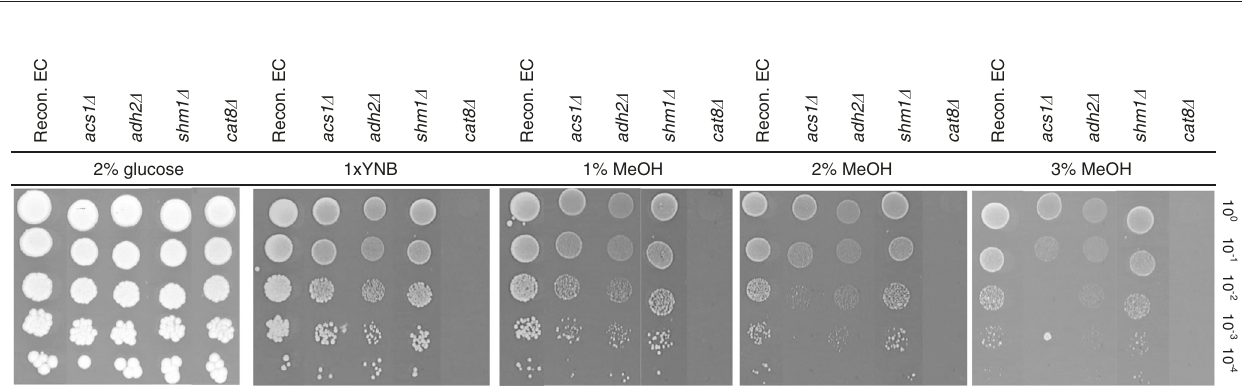
Fig. 4 Characterisation of the reconstructed evolved strain at the metabolite, transcriptome and proteome level compared with the parental strain during 13 C-methanol fermentations. Percentage of 13 C-labelled intracellular metabolites in CEN.PK 113-5D (black) and the reconstructed evolved strain (purple). Metabolites are fully labelled with 13 C. Data points represent the average of two independent biological replicates with standard deviation. Transcript and protein abundance in the reconstructed evolved strain compared with the parental strain. Genes with up- or downregulated fold-changes and adjusted p values <0.01 are coloured blue or yellow, respectively. Increased or decreased protein abundance and adjusted p values <0.05 is shown in blue or yellow arrows, respectively. ND not detected. The metabolic map was redrawn based on ref. 58 . Metabolite abbreviations: MeOH methanol, FORM formaldehyde, DHA dihydroxyacetone, DHAP dihydroxyacetone phosphate, Xu5P xylulose-5-phosphate, G6P glucose-6-phosphate, F6P fructose-6- phosphate, F,6BP fructose-1,6-bisphosphate, GAP glyceraldehyde-3-phosphate, 1,3BPG 1,3-bisphosphoglycerate, 3PG 3-phosphoglycerate, 2PG 2-